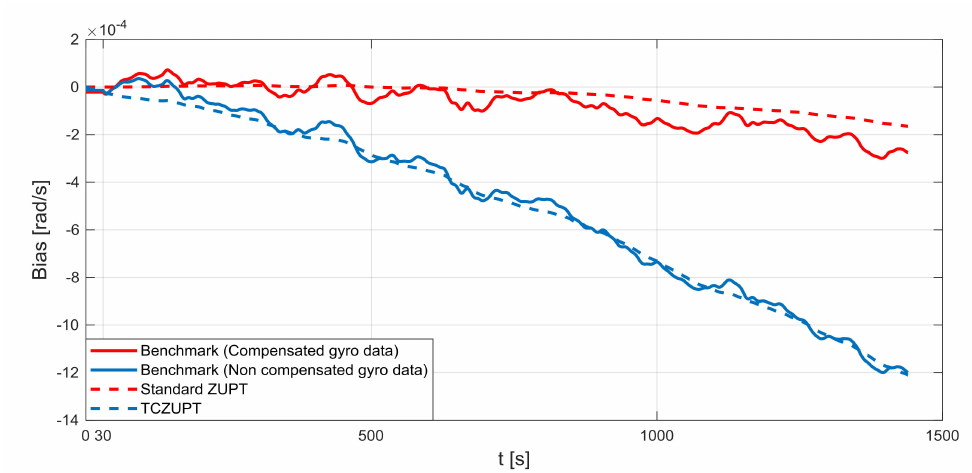
Figure 13. Gyro output bias (nominal condition, z